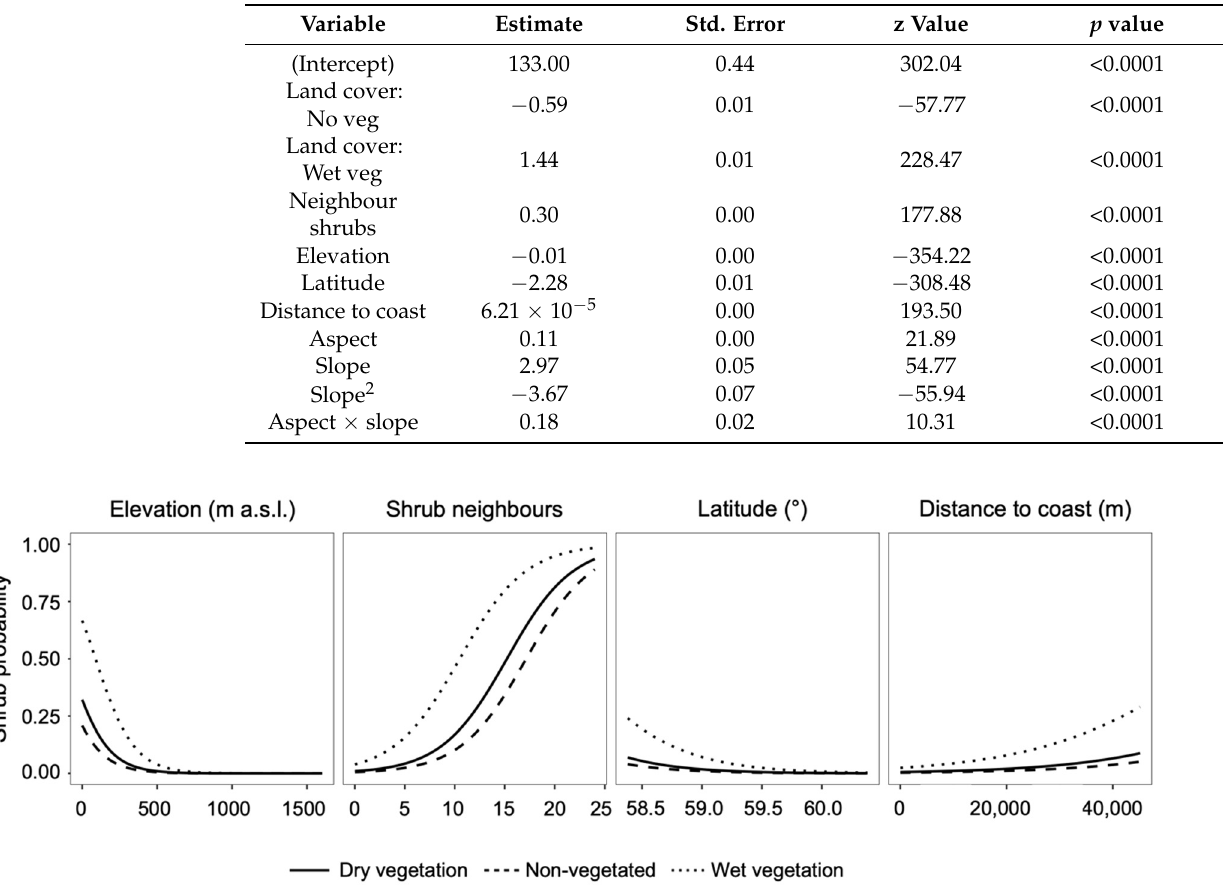
Table 3. Model output of the selected binomial regression model in which the probability of a pixel being shrub dominant at time 2 (2014) was estimated from topographic and biotic variables at time 1 (1985/89).